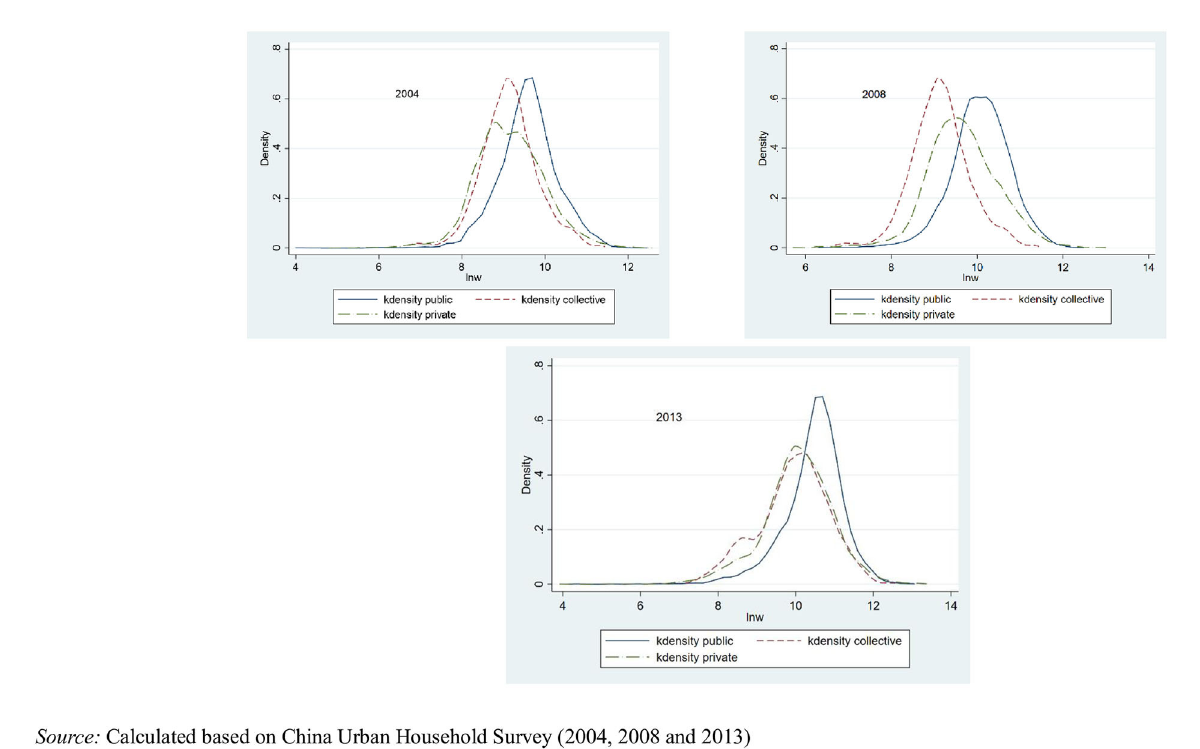
FIGURE4 Kernel density distribution of wages by sector for 2004, 2008, and